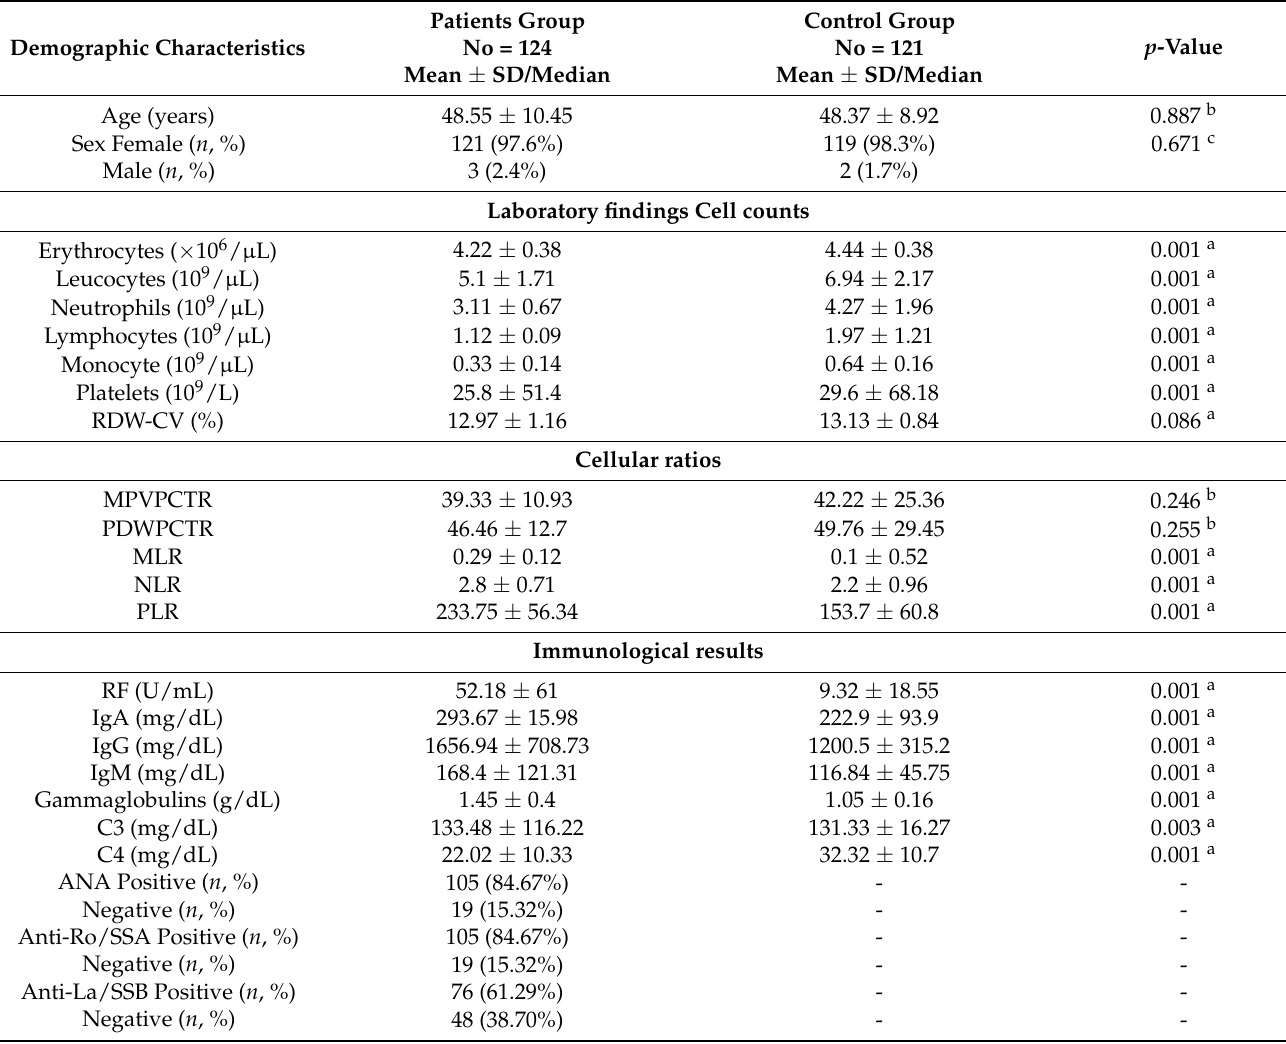
Table 1. Demographic and laboratory results of patients and control